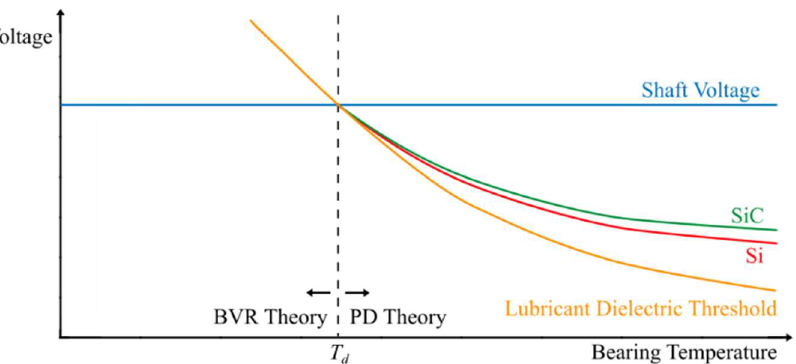
Figure 21. Comparison of the lubricant dielectric threshold at dc (yellow), and shaft discharge voltages produced by Si (red) and SiC (green) inverters. The shaft voltage amplitude as set by the BVR is shown in blue. The temperature at which discharges are first observed is denoted T d .